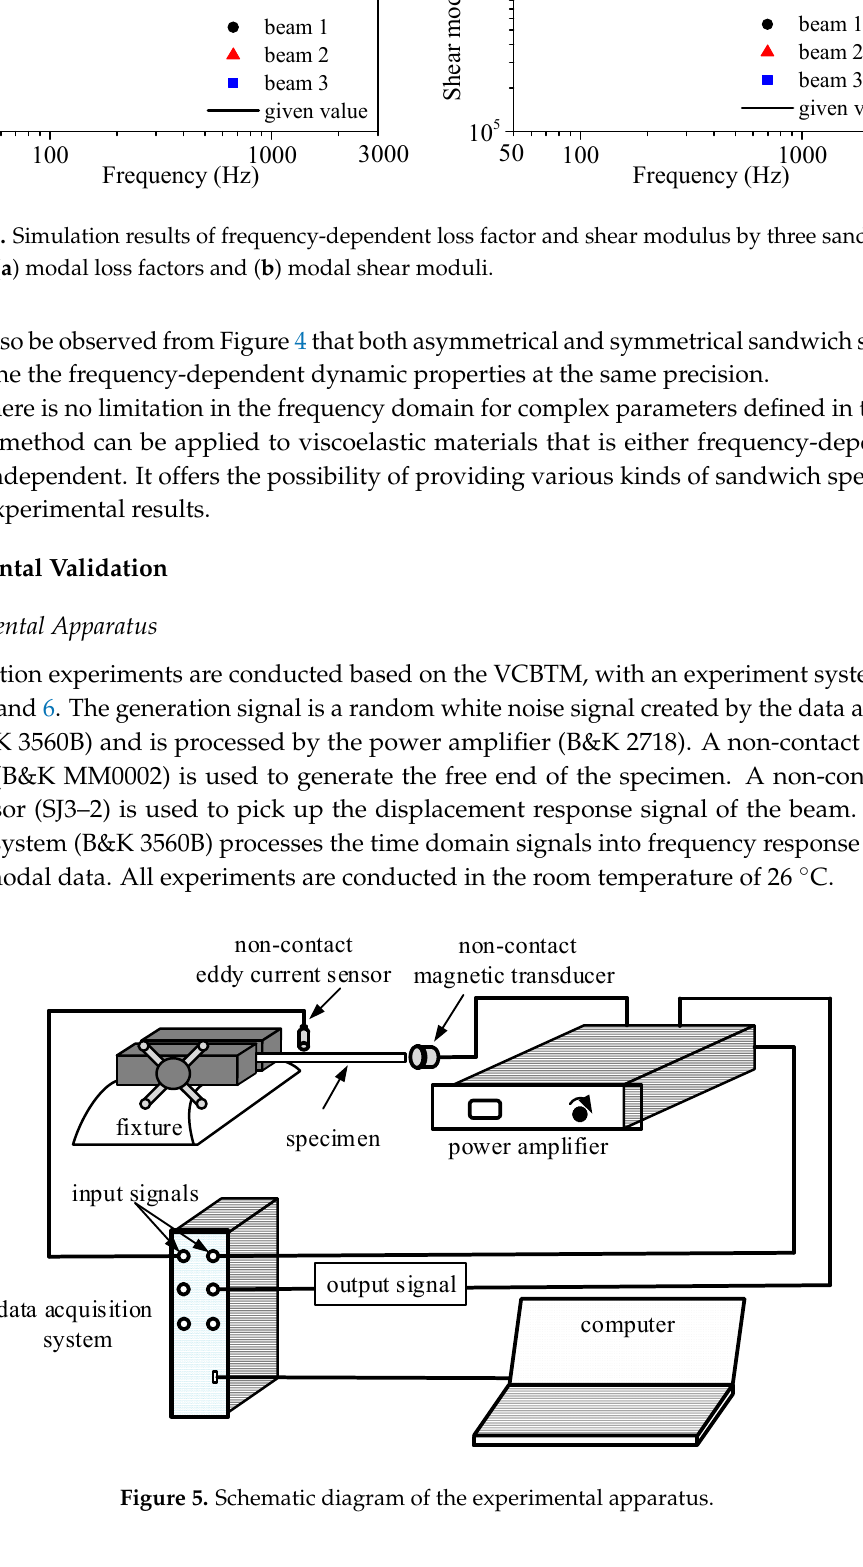
Figure 6. Experimental setup. 4.2. Test Specimens As shown in Figure 7, three different sandwich beam specimens are prepared to measure the dynamic mechanical properties of one self-adhesive viscoelastic damping material (VDM). The asymmetry types include the asymmetry of base beams’ thickness and the asymmetry of materials. The short asymmetrical specimen is 180-mm-long and consists of a 0.90-mm-thick steel base beam and a 1.02-mm-thick steel base beam; the long asymmetrical specimen is 240 mm long and contain a 0.97-mm-thick steel substrate beam and a 0.90-mm-thick aluminium substrate beam; the long symmetrical specimen is 240 mm long and is composed of two 0.97-mm-thick steel base beams. All the test specimens are 10 mm wide and has identical self-adhesive VDM core with the thickness of 0.5 mm. The densities of the steel, aluminium and VDM are measured as 7830 kg/m 3 , 2710 kg/m 3 , 1600 kg/m 3 , respectively.